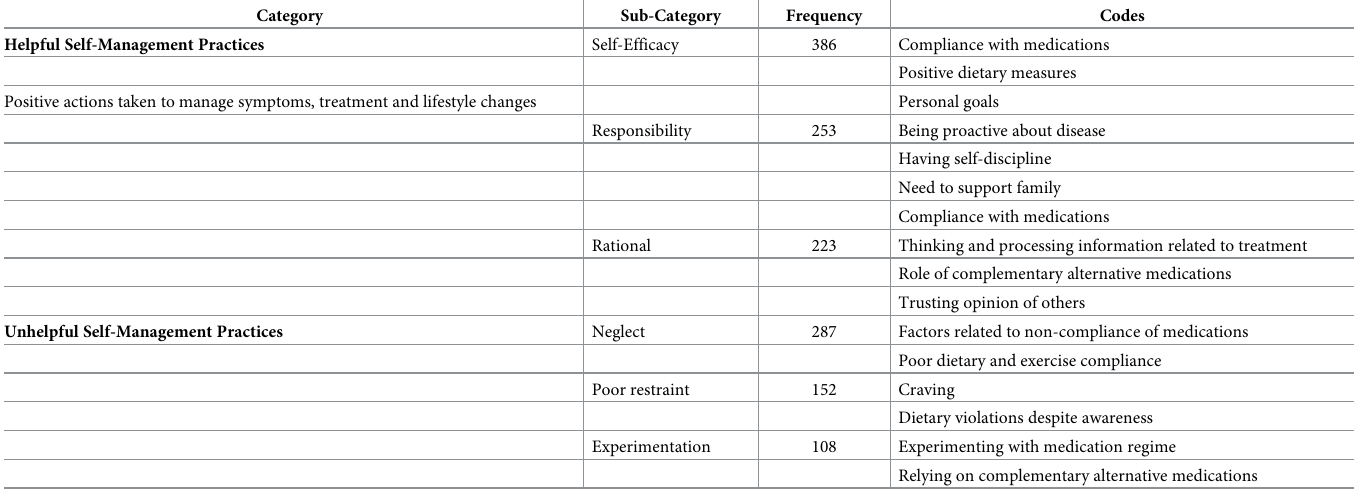
Table 3. Categories, definitions, frequency, and codes describing self-management practices of T2D